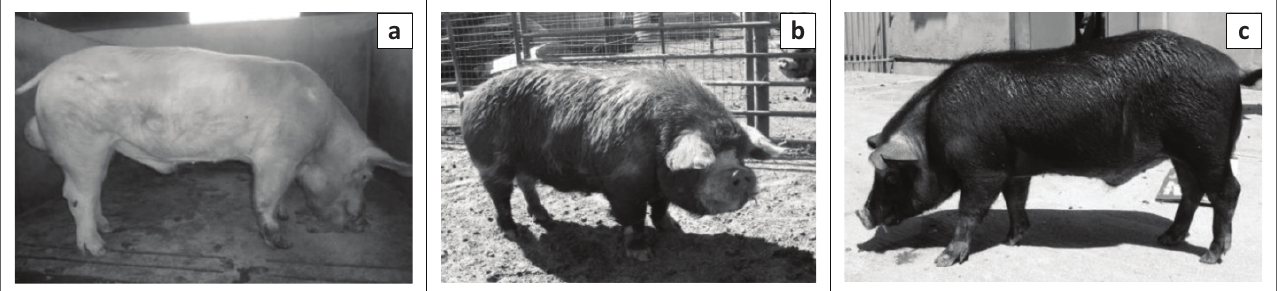
FIGURE 4: Images showing the differences in the appearance of the three breeds of pigs used in this study. (a) Large White; (b) Kolbroek and (c)